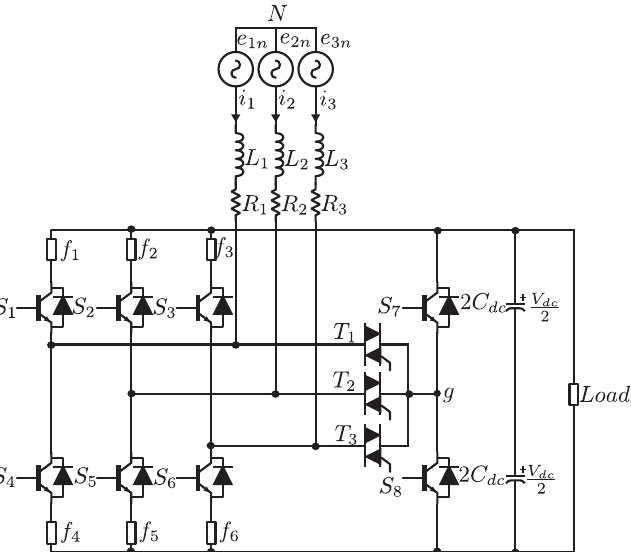
Figure 4. Fault-isolation at the switch level.The defective switch is isolated, and control commands are redirected to the redundant switch.